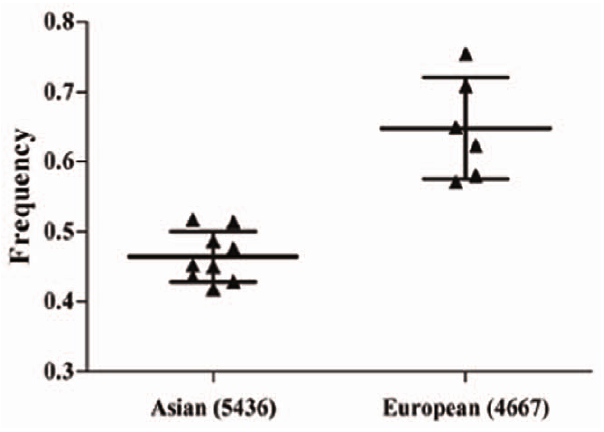
Figure 2. Frequencies of the variant alleles (C allele) among controls stratified by ethnicity. Black trangle m represents each included